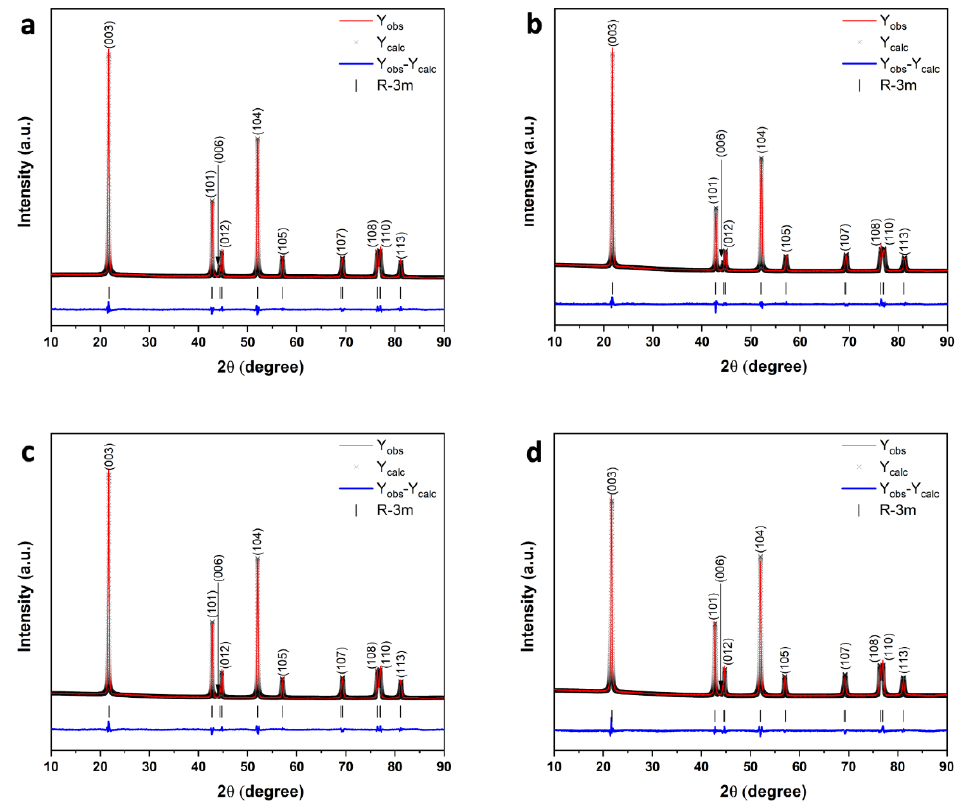
Figure 5. Experimental (black), calculated (red) and difference (blue) powder XRD patterns of the MW_15m_A ( a ), MW_30m_A ( b ), MW_60m_A ( c ) and CP_A ( d ) samples after Rietveld refinement. Bragg reflection positions (sp. gr. R 3(cid:3364) m ) are marked with black vertical lines. Table 1. Crystallographic data after the Rietveld refinement for the LiNi 0.8 Mn 0.1 Co 0.1 O 2 samples.